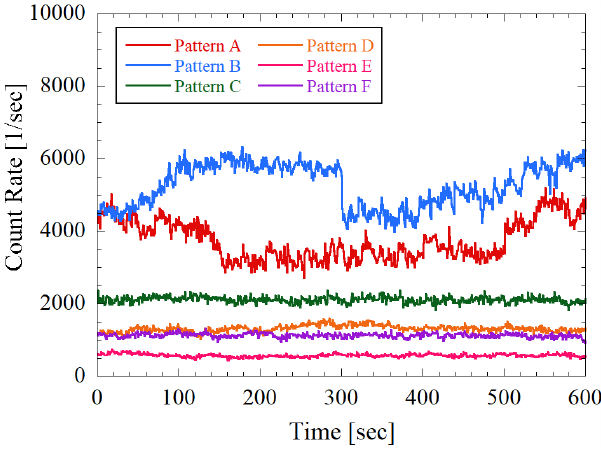
Figure 3. Time variation in neutron count